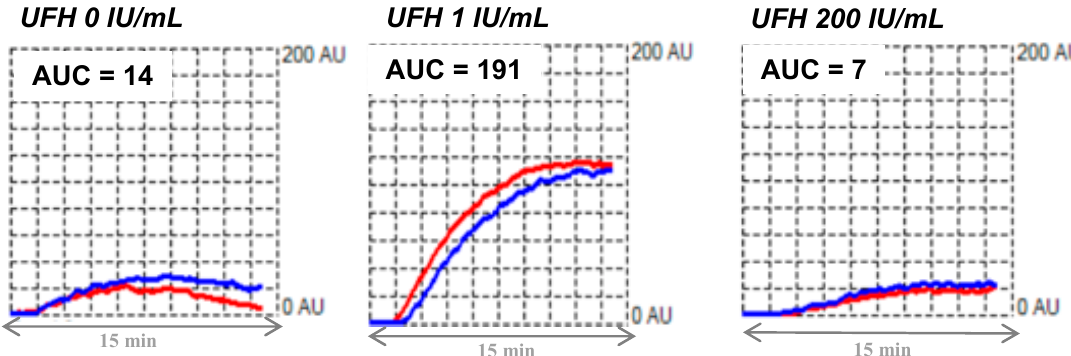
Figure 4. Typical tracing obtained by whole blood impedance aggregometry. Presence of HIT antibodies activating platelets: typical tracings obtained by whole blood impedance aggregometry (Multiplate ® ) in the absence and in the presence of low (1 IU/mL) and high (200 IU/mL) concentrations of UFH. The whole blood aggregation is recorded for 15 min. AUC: area under curve.